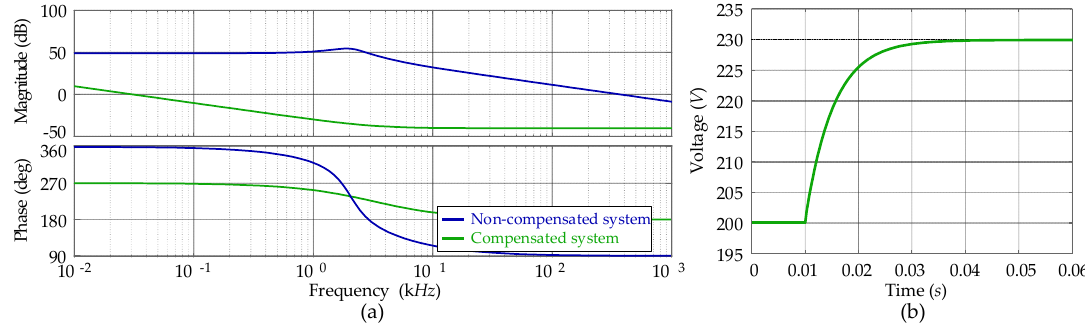
Figure 12. Simulation results: ( a ) Open-loop frequency response of the converter without compensator and with compensator for the battery discharging mode, ( b ) closed-loop step response.